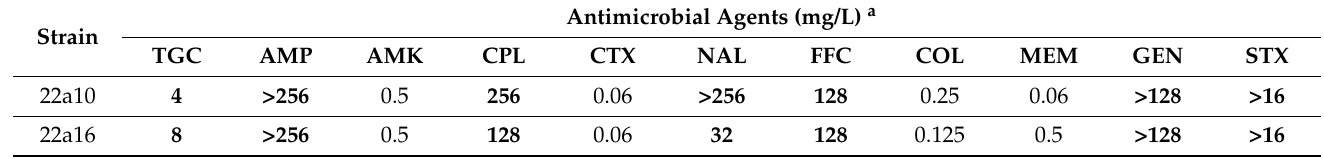
Table 1. The MIC of 6 tet (X4) − positive E. coli